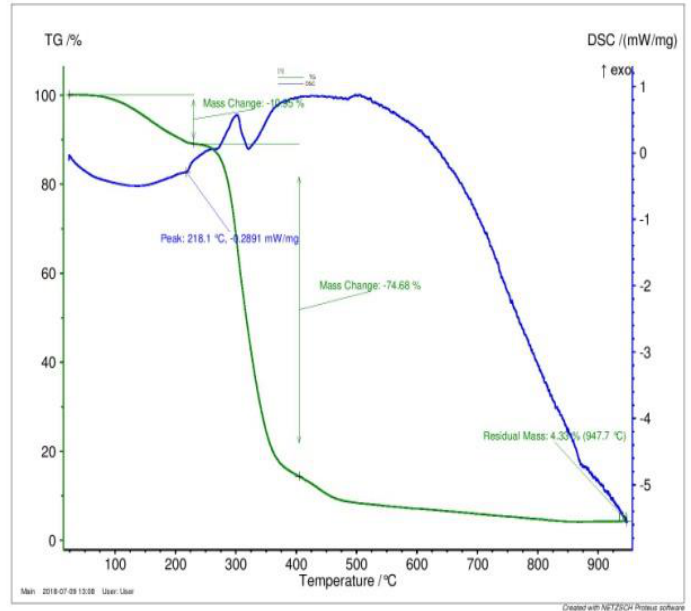
Figure 9. TGA and DSC curve of cellulose-PVA composite.